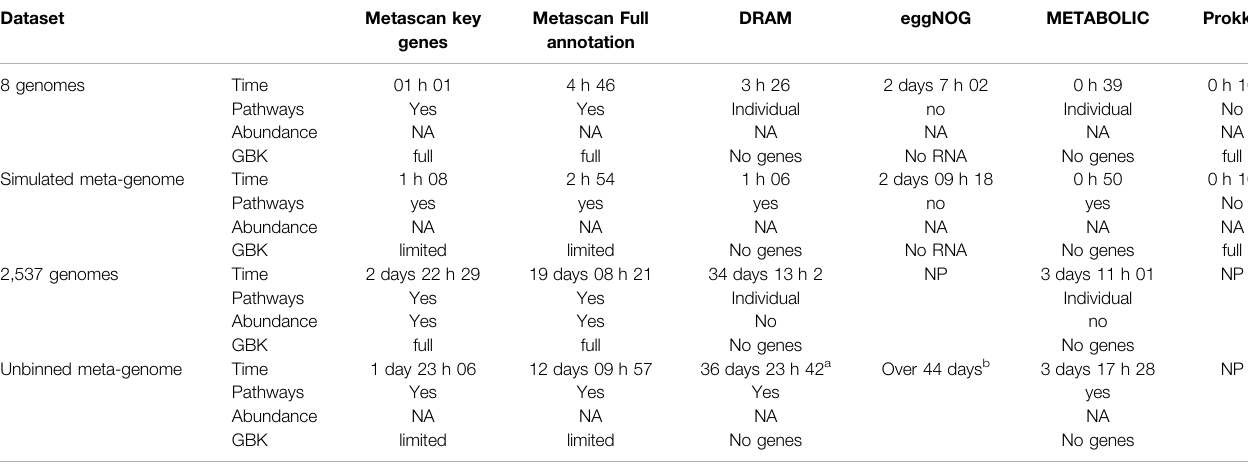
TABLE2| Overviewofdifferentanalysisoptions,analysistimesandpropertiesperdataset.Timeisthetotalanalysistime.Pathwaysindicatewhethertheresultsareordered byecological pathways and processesintheoutput.Abundance showstheoptiontoincludedepth valuesintotheanalysisand GBK indicates thestateoftheGenbank fi le that is created by the program.